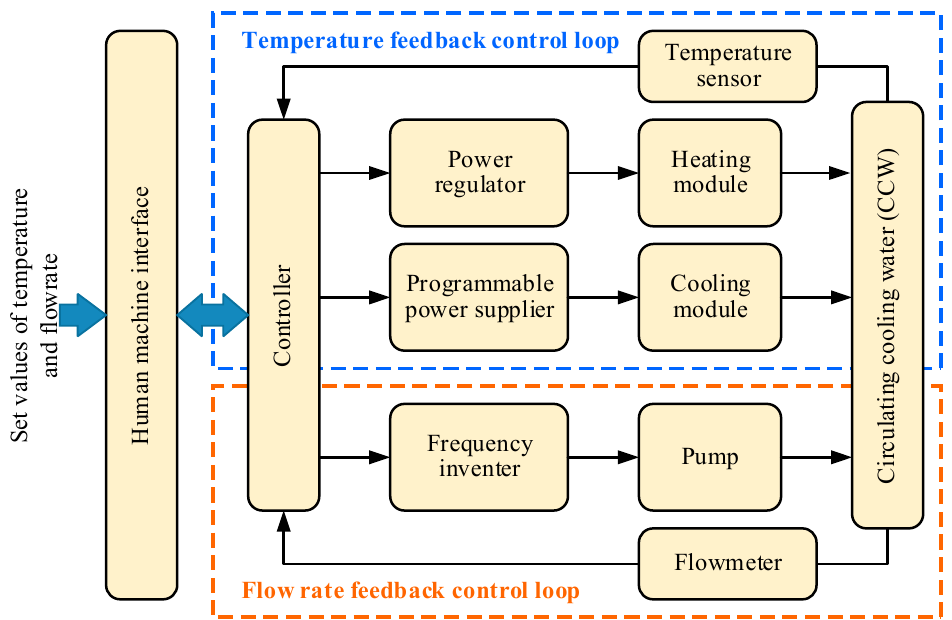
Figure 8. Schematic diagram of the control sub-system of the enhanced CCW machine.